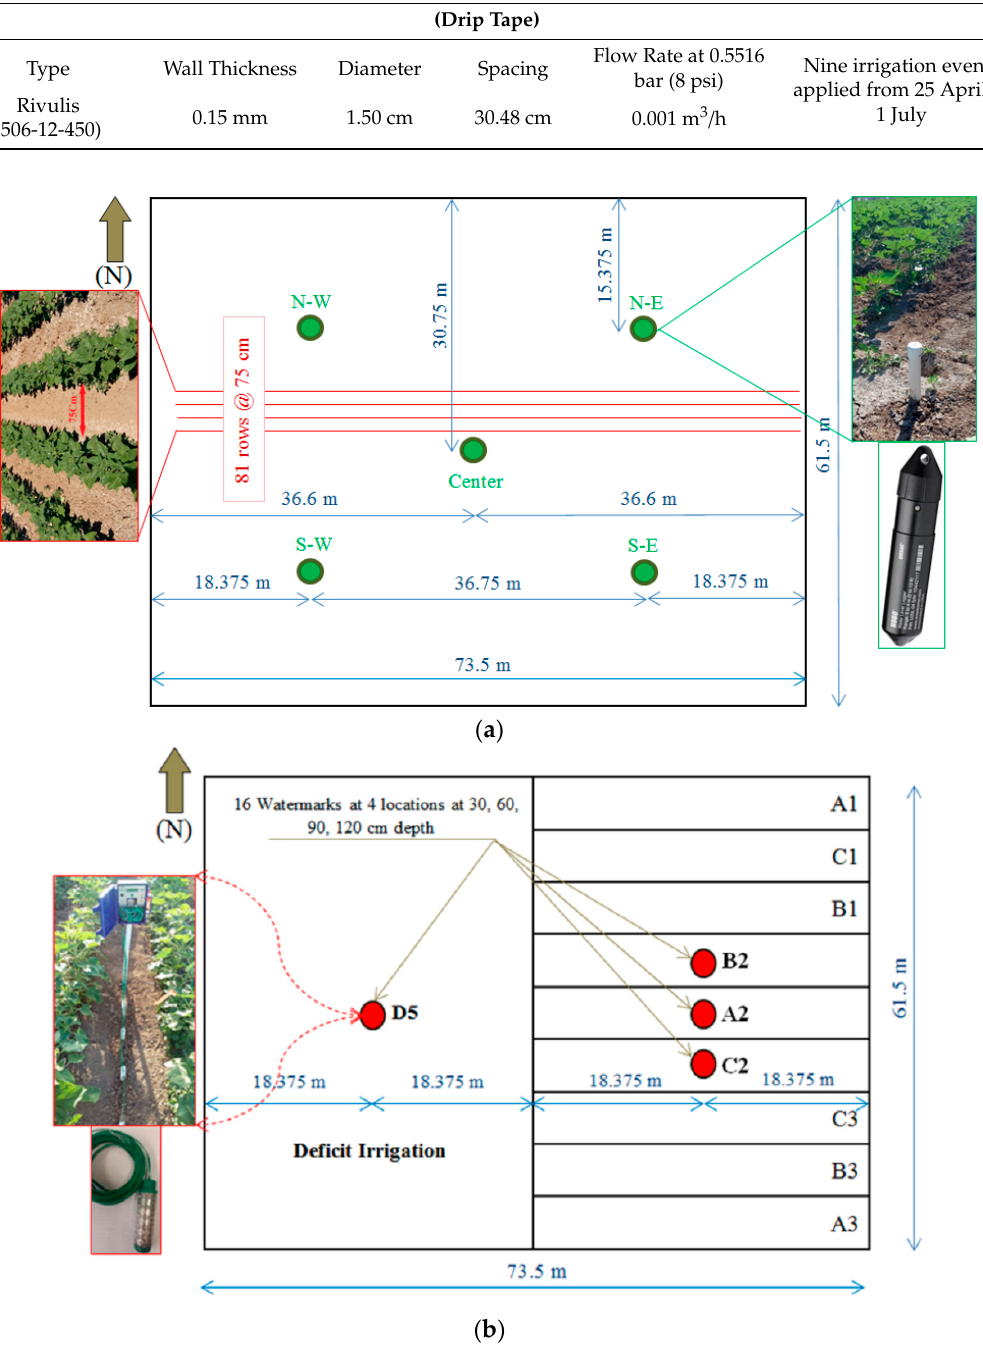
Figure 4. ( a ) Field dimensions and locations of observation wells (green circles). ( b ) The layout of irrigation treatments showing deficit irrigation in the western section and the replicates of the full and reduced irrigation treatments (A, B, and C) in the eastern section (nine zones total, nine rows